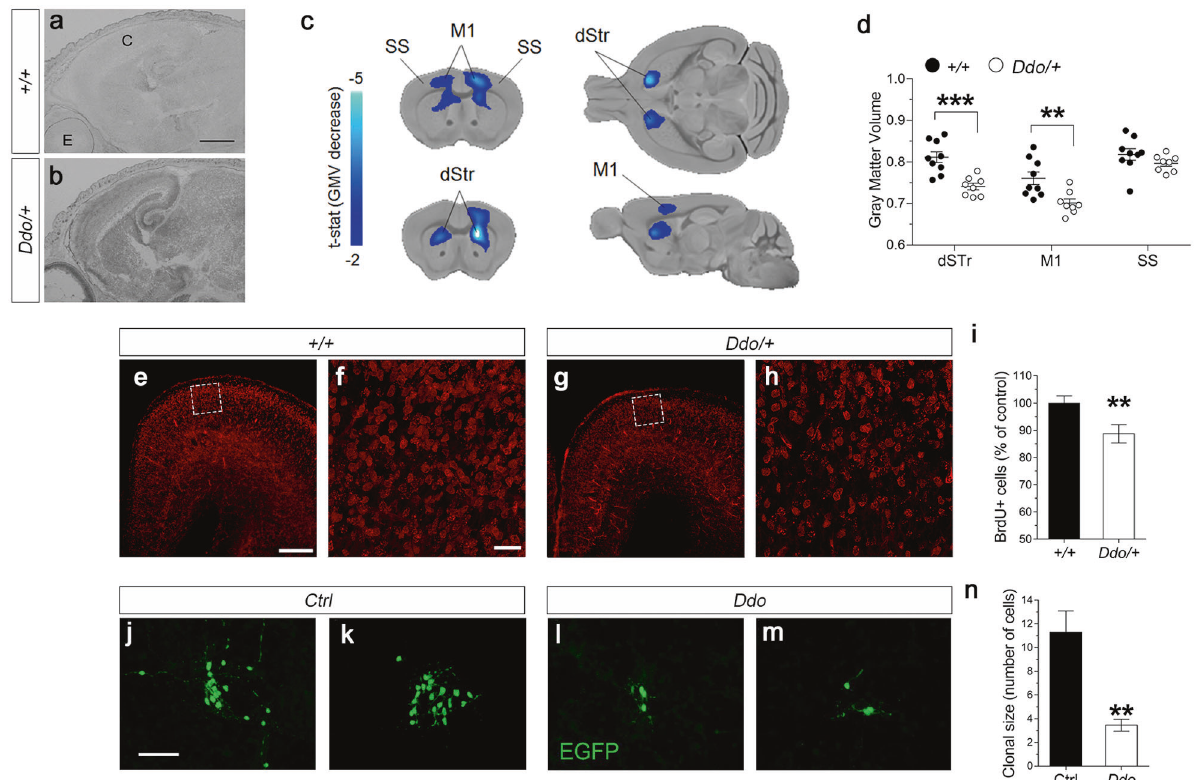
Fig. 1 Reduced gray matter volume in motor cortex and striatal regions of adult Ddo knockin mice and lower number of cortical neurons in the dorsal pallium of newborn pups. a , b Representative images of sagittal sections showing Ddo expression in ( a ) R26 + / + and ( b ) R26 Ddo/ + pups at birth. C cortex, E eye. Scale bar 1 mm. c High-resolution structural MRI revealed a prominent reduction of gray matter volume (GMV) in cortical and striatal areas of R26 Ddo/ + compared to R26 + / + mice. d Regional volumetric analysis of GMV in R26 + / + and R26 Ddo/ + mice in dorsal striatum (dStr), primary motor cortex (M1) and somatosensory cortex (SS). e – i Birth-dating experiment of embryos injected with BrdU at E14.5. e – h Representative coronal sections showing BrdU-positive neurons in ( e , f ) R26 + / + and ( g , h ) R26 Ddo/ + mice at birth. f , h Confocal higher magni fi cation of the boxed region in the dorsal pallium. Images further demonstrate the reduced density of BrdU-positive cells in ( h ) R26 Ddo/ + pups as compared to ( f ) R26 + / + controls. Scale bars: ( e , g ) 250 μ m, ( f , h ) 50 μ m. i Bar graph showing the reduction of the BrdU-positive cells in the dorsal pallium of R26 Ddo/ + pups. j , m Representative images of clones generated by single E14 telencephalic progenitor cells transduced with retroviral vectors. Scale bar 100 µm. n Bar graph showing the average size of clones generated by the transduced progenitor cells ( n = 6, total number of clones, Ctrl: 335, Ddo : 260). All data are expressed as mean ± SEM. ** p < 0.01; *** p < 0.0001, compared with control group (Student ’ s t